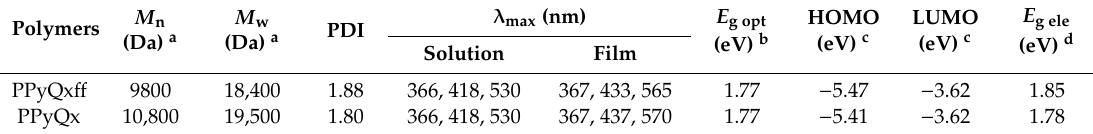
Table 1. Characteristics of (PPyQxff) and (PPyQx).